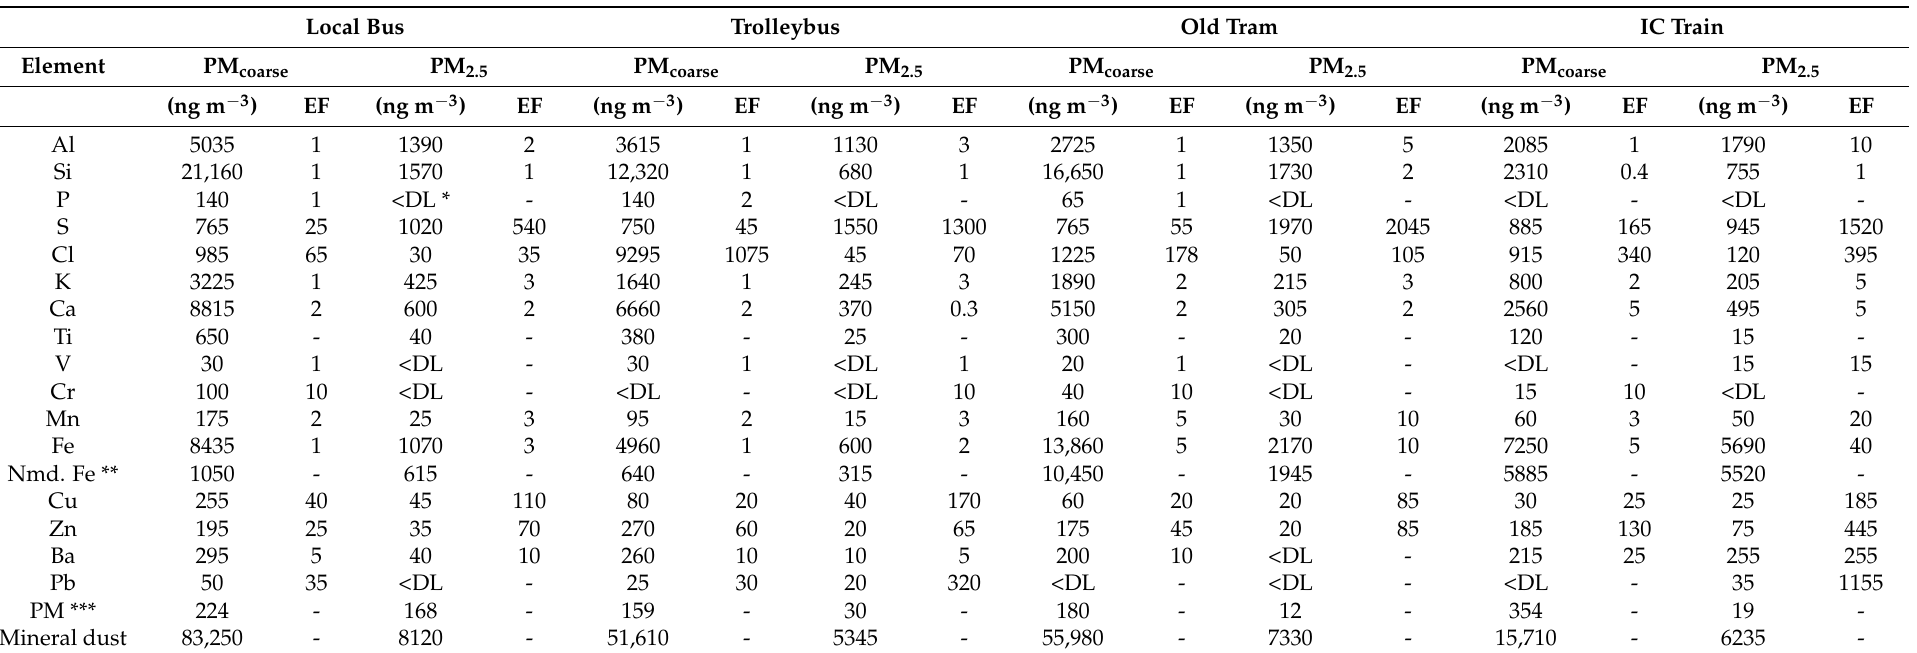
Table 4. Elemental concentration, mineral dust concentration and enrichment factor (EF) in PM coarse and PM 2.5 fractions in different vehicles in